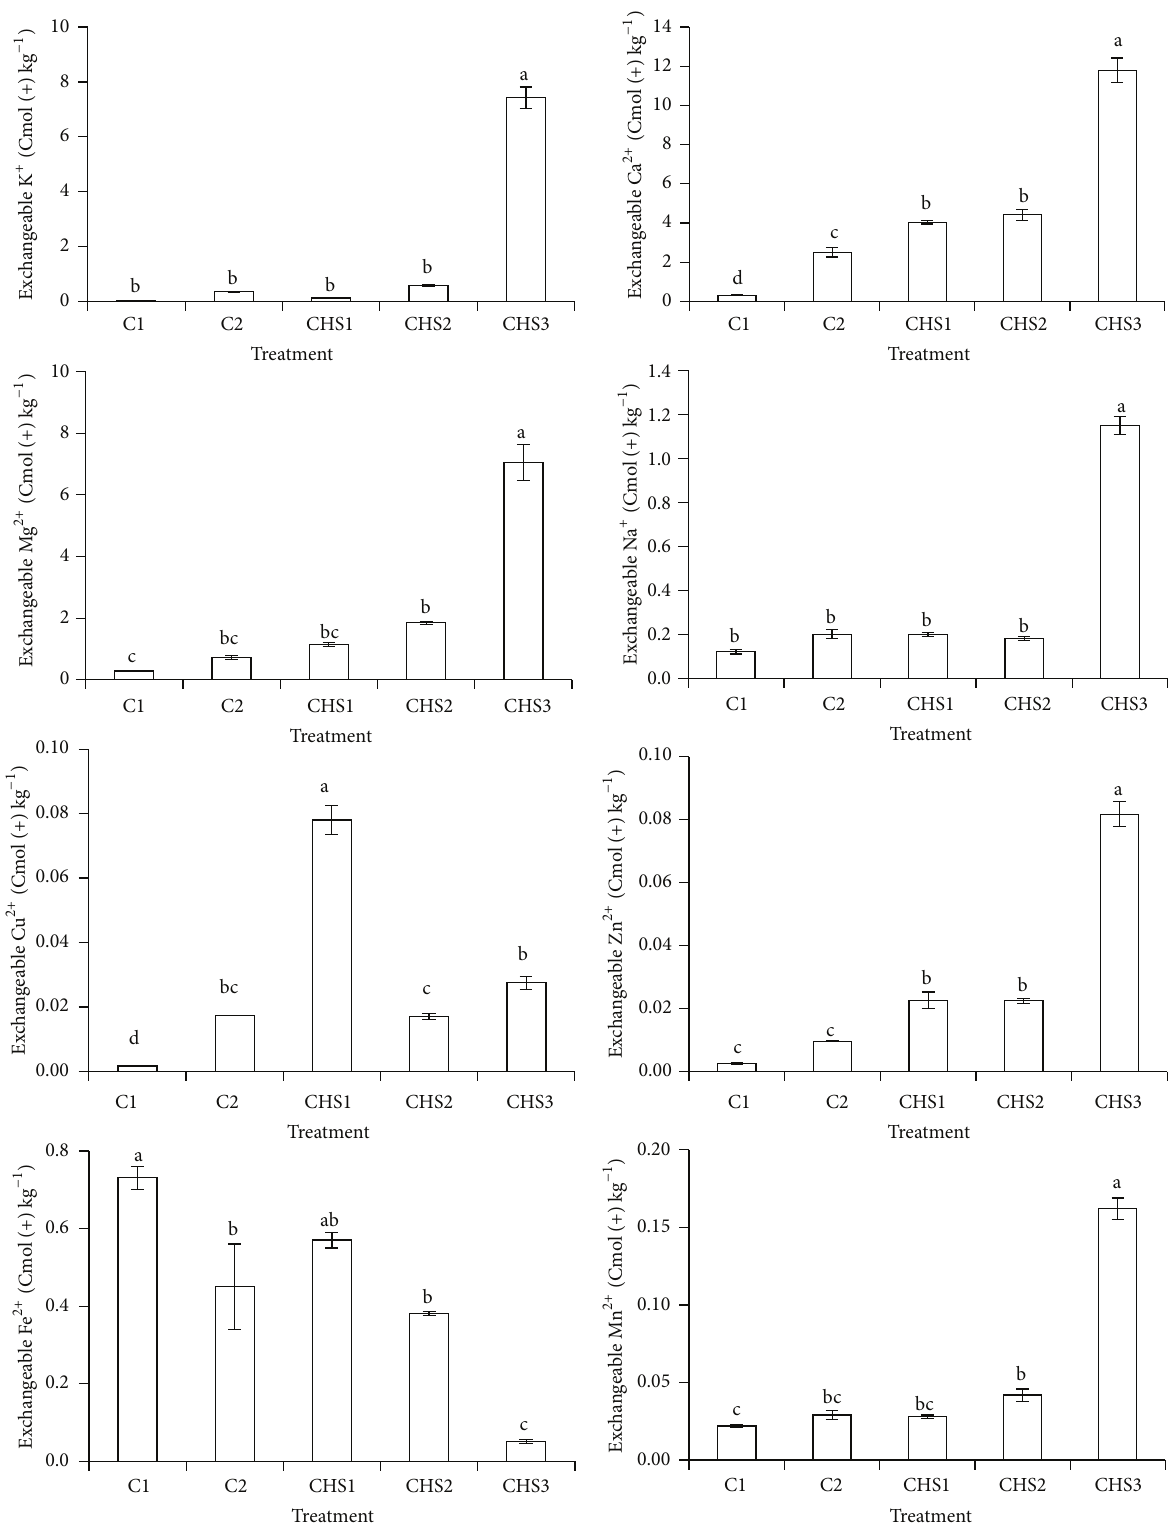
Figure 9: Treatments (C1: soil alone, C2: soil + complete fertilization, CHS1: soil + complete fertilization + 20 g rice straw compost + 2 g sawdust ash, CHS2: soil + complete fertilization + 40g rice straw compost + 4g sawdust ash, and CHS3: soil + complete fertilization + 60 g rice straw compost + 6g sawdust ash) effect on selected soil exchangeable cations (K + , Ca 2+ , Mg 2+ , Na + , Cu 2+ , Zn 2+ , Fe 2+ , and Mn 2+ ) content at 90 days after seeding. Different alphabets indicate significant difference between means using Tukey’s test at 𝑃 ≤ 0.05 . The error bars are the ± standard error of